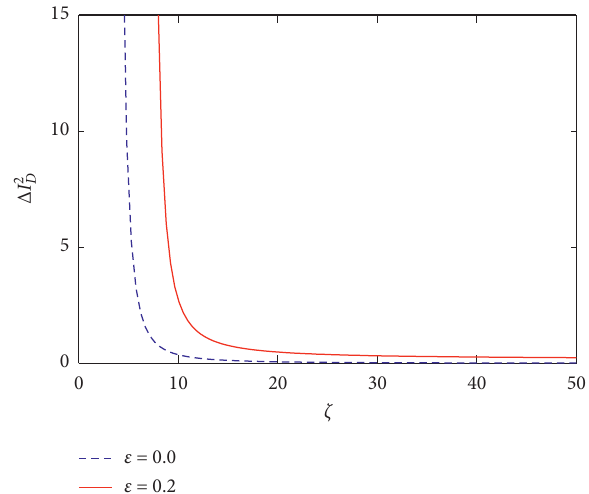
Figure 10: Plots of the steady state intensity difference fluctuation (equation (64)) versus ζ for κ � 0 . 8, r � 0 . 75, and A � 2 . 50 and for different values of ε .